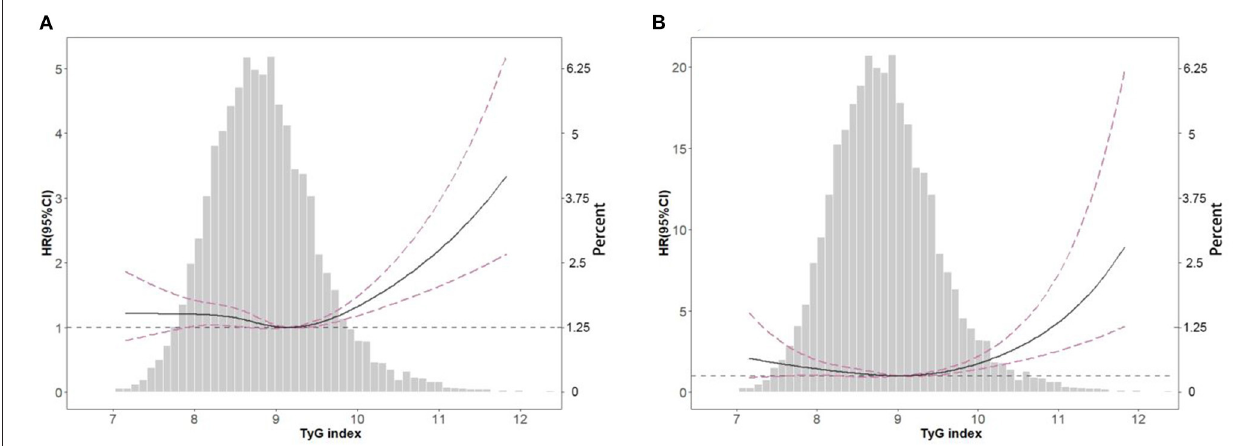
FIGURE 2 | Spline analyses of all-cause (A) and cardiovascular (B) mortality by TyG index in the overall cohort and the probability distribution histogram is represented in the background (spline analyses were adjusted for age, gender, race, smoking, marital status, education level, body mass index, systolic blood pressure, estimated